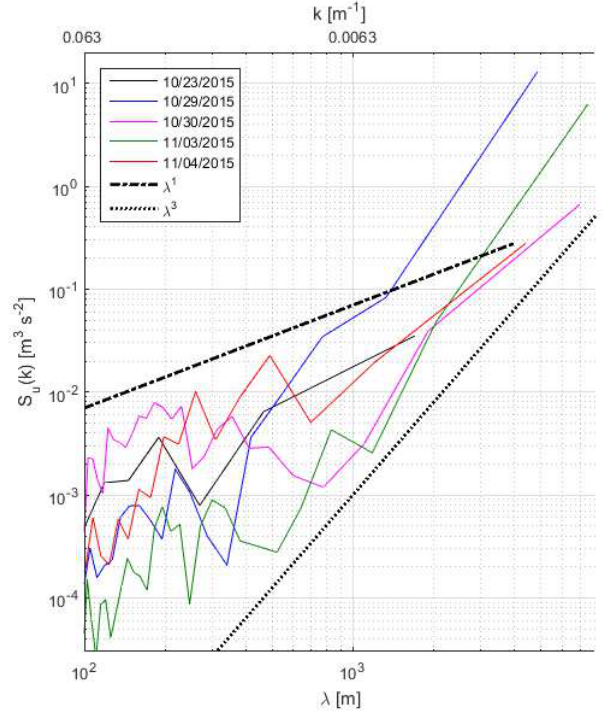
Figure 13. Velocity power spectra calculated based on the dye plume velocimetry shown in Figure 12. Dash-dotted curve is the same as in Figure 11 and Equation (4). A λ 3 power law is given for reference with a dotted line.